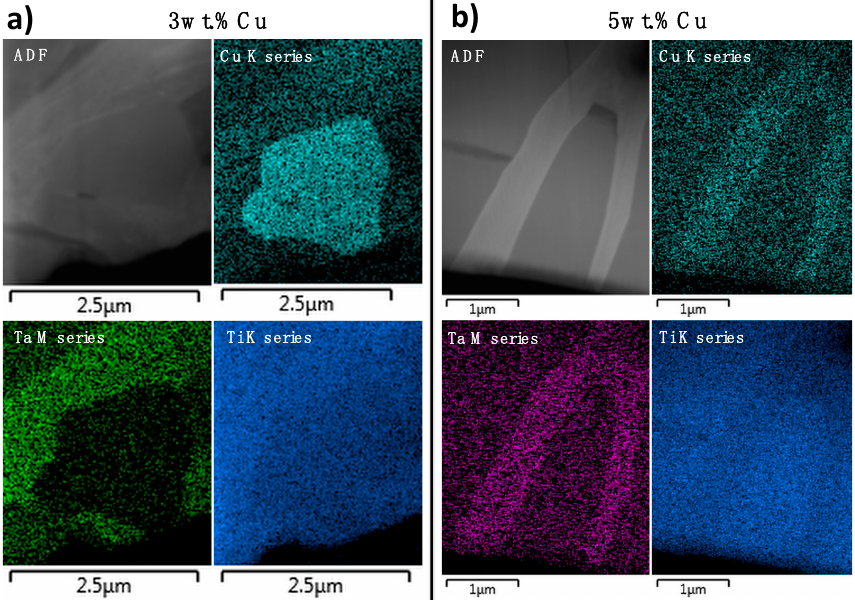
Figure 4. STEM-EDS maps on the crystal boundary showing 3 crystal phases for ( a ) 3 wt.% Cu alloy and ( b ) 5 wt.% Cu alloy, with associated Annular dark field detector image, Cu K series map, Ta M series map and Ti K series map.